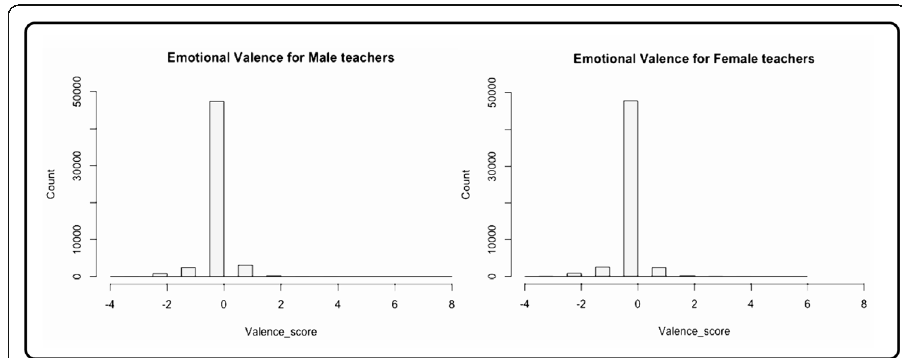
Fig. 7 Sentiment analysis and implementation outcomes of the EPDM model by teachers ’